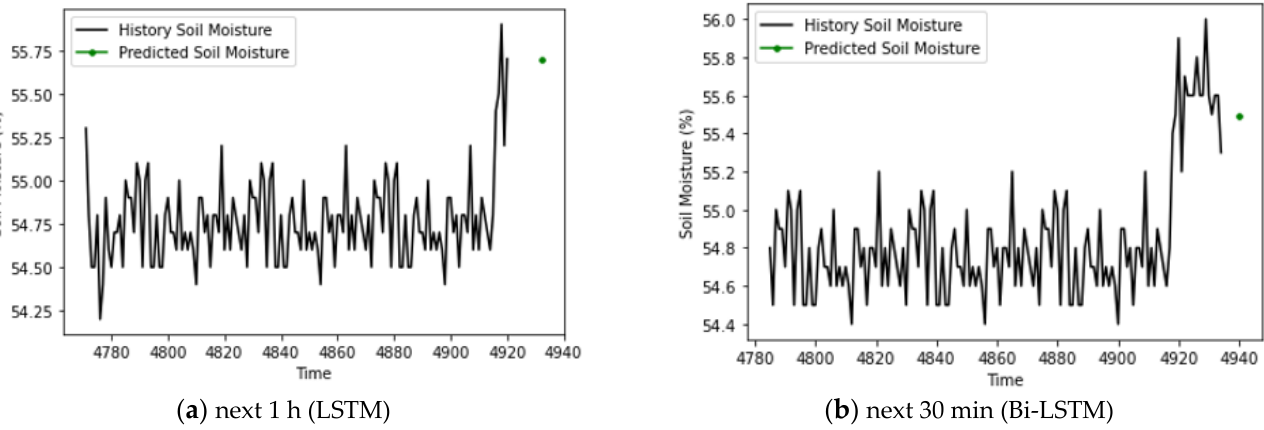
Figure 9. Zoom in of the red box in Figure 8 ( a ) and Figure 8 ( b )